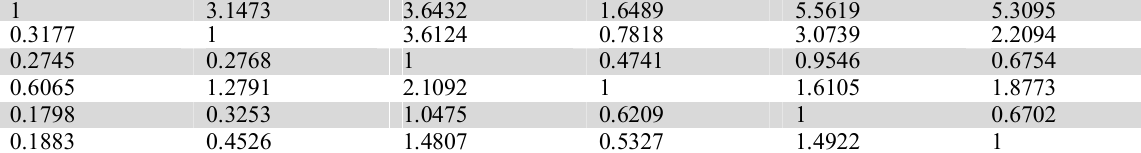
Mean value of Combined Fuzzy Triangular of Expert’s Viewpoint